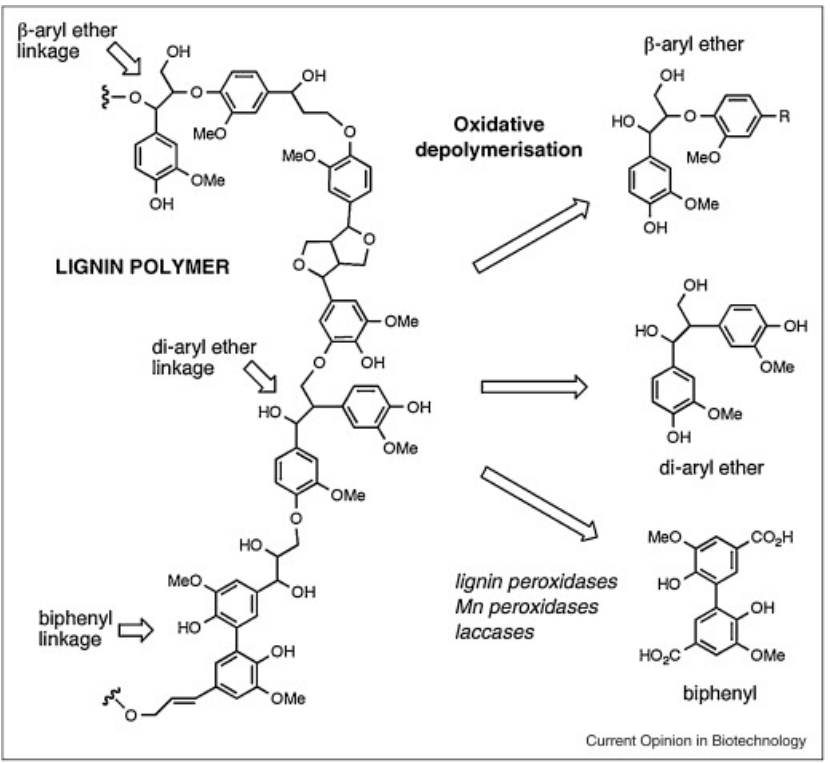
Figure 3. Lignin degradation by lignin modifying enzymes, Timothy et al., The emerging role for bacteria in lignin degradation and bio-product formation, published by Elsevier, 2020